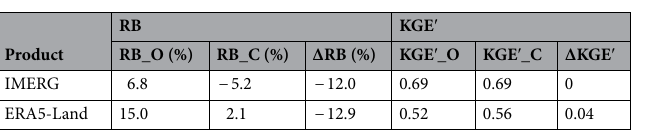
Table 3. Overall continuous metrics for IMERG and ERA5-Land over the whole of China.